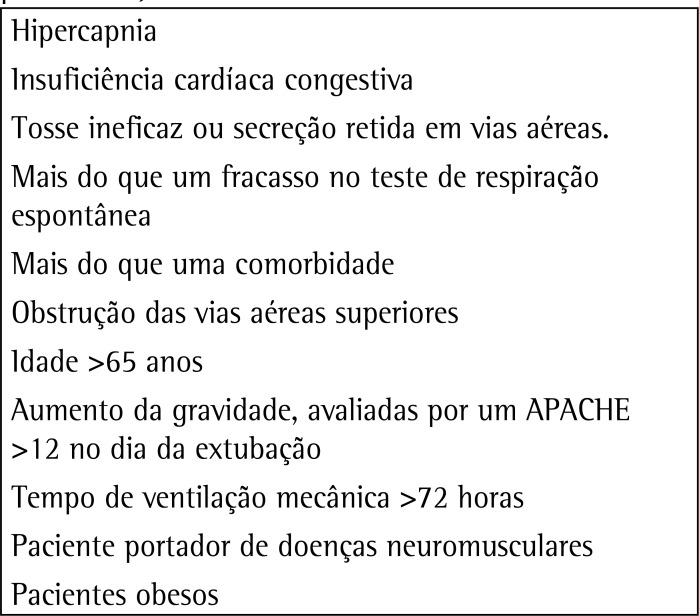
Pacientes considerados em risco de falha de extubação que poderão se
beneficiar do uso de ventilação não invasiva imediato após extubação (uso
profilático)